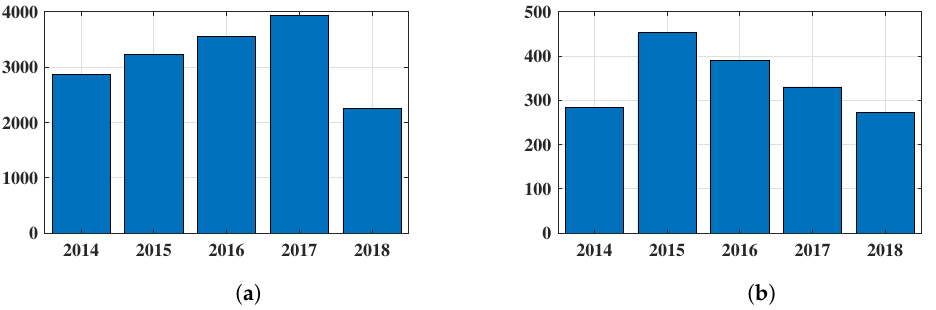
Figure 1. Analysis of publication statistics in the IPS research field: ( a ) publication statistics of IPSs during last five year; and ( b ) publication statistics of IPSs where RSSI has been considered as potential